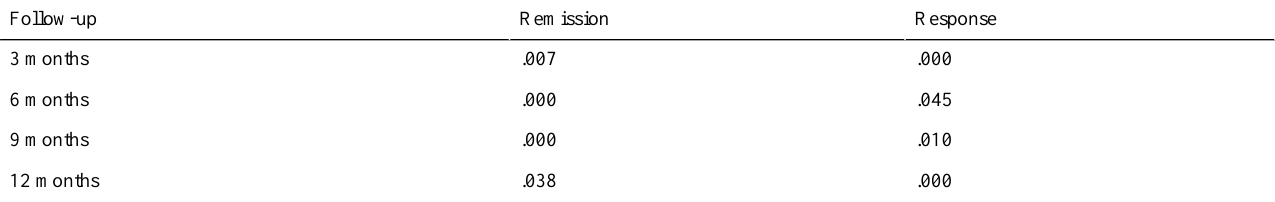
Table 2. Estimated intraclass correlation coefficients (ICCs) for remission and response for each measurement occasion. a